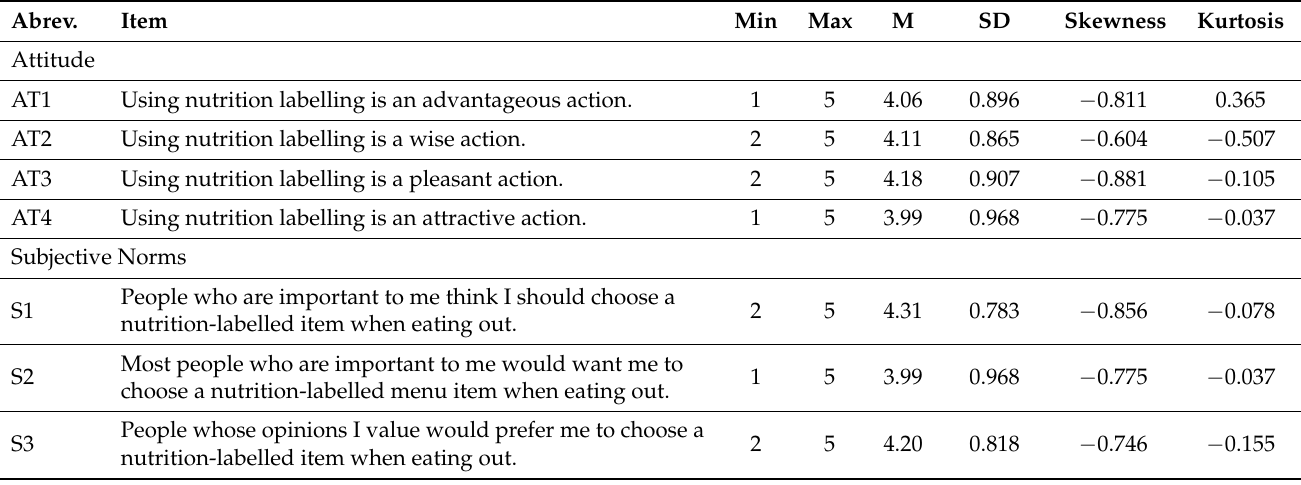
Table 2. The descriptive statistics for the research